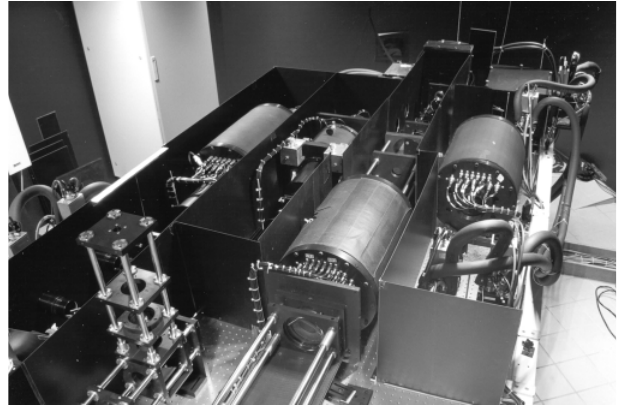
Fig. 6. Overview of the detection system, mounted on a 3.6 · 1.5 m optical table, and with top covers removed. This view of the optical table is from the detector side towards the input side. From the left to right can be seen the housings of the 532 nm etalon, 1064 nm etalon, the DWTS etalon, and the 355 nm etalon. At the right upper corner is the ‘‘box’’ containing filters and the detectors for the rotational Raman channels RR1 and RR2